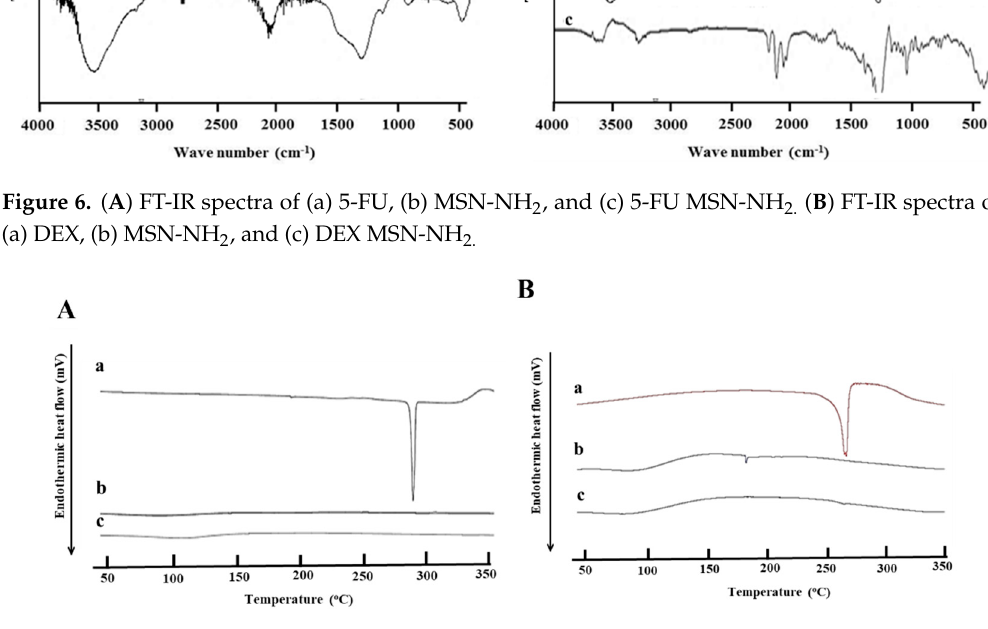
Figure 7. ( A ) DSC Thermograms of (a) 5-FU, (b) MSN-NH 2 , and (c) 5-FU MSN-NH 2 . ( B ) DSC thermograms of (a) DEX, (b) MSN-NH 2 , and (c) DEX MSN-NH 2.